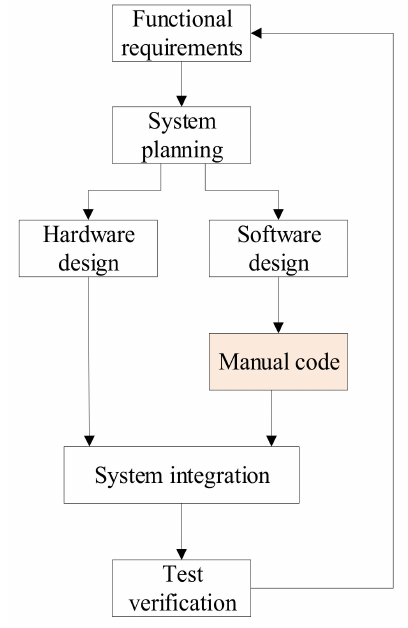
Figure 1. The traditional development model.